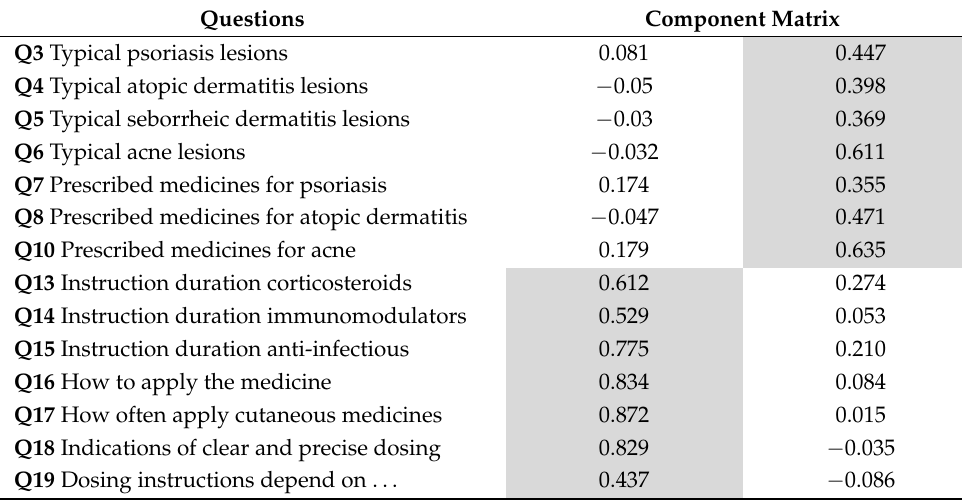
Table 4. Final exploratory factorial analysis